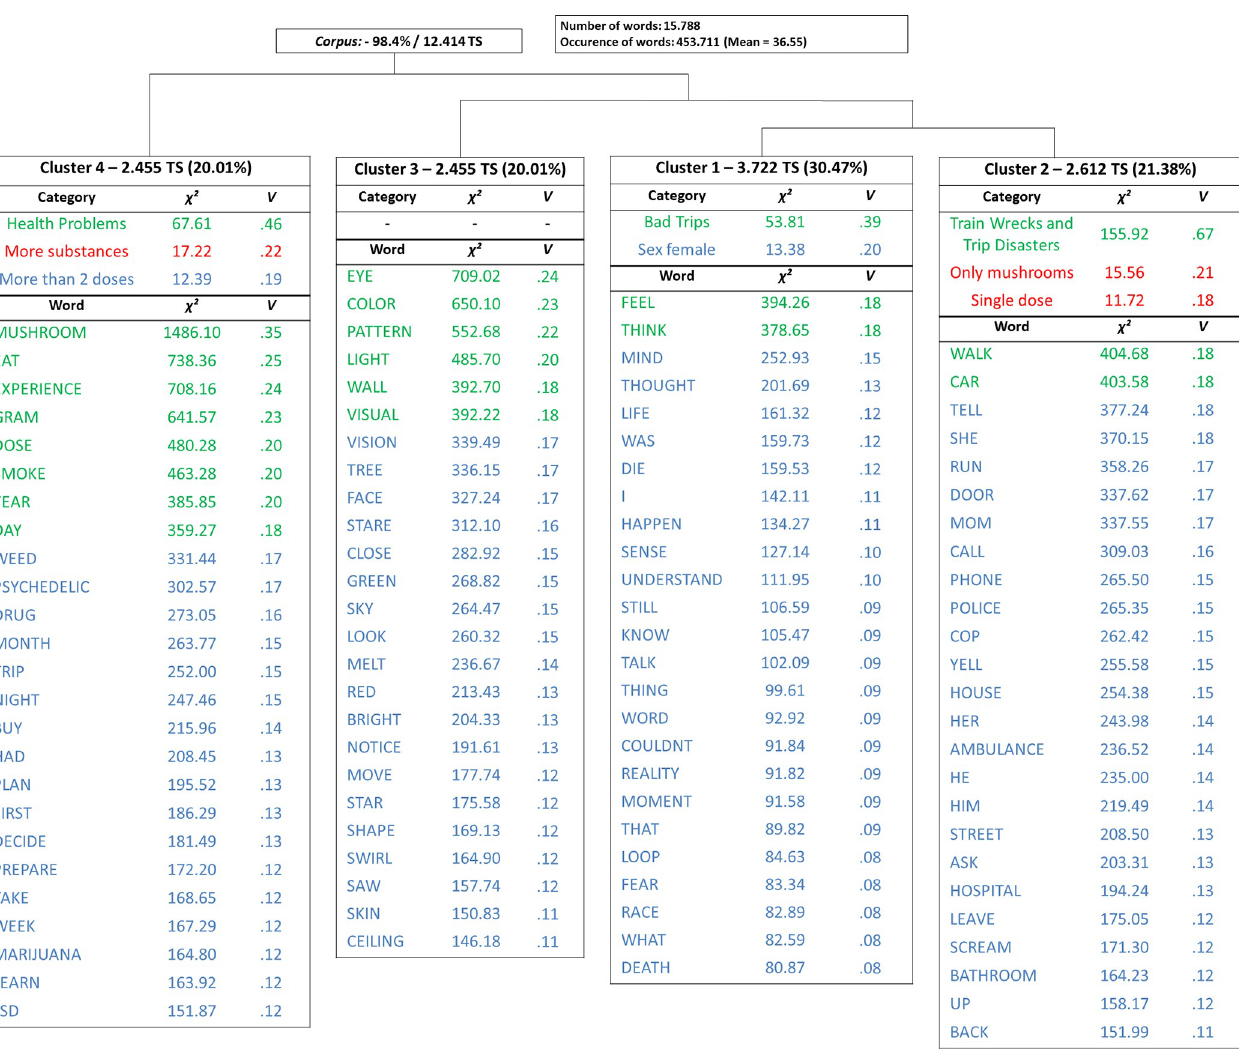
Fig 1. Dendogram with the 25 words with highest χ 2 in each cluster. Small (red), medium (blue) and large (green) effect sizes, according to